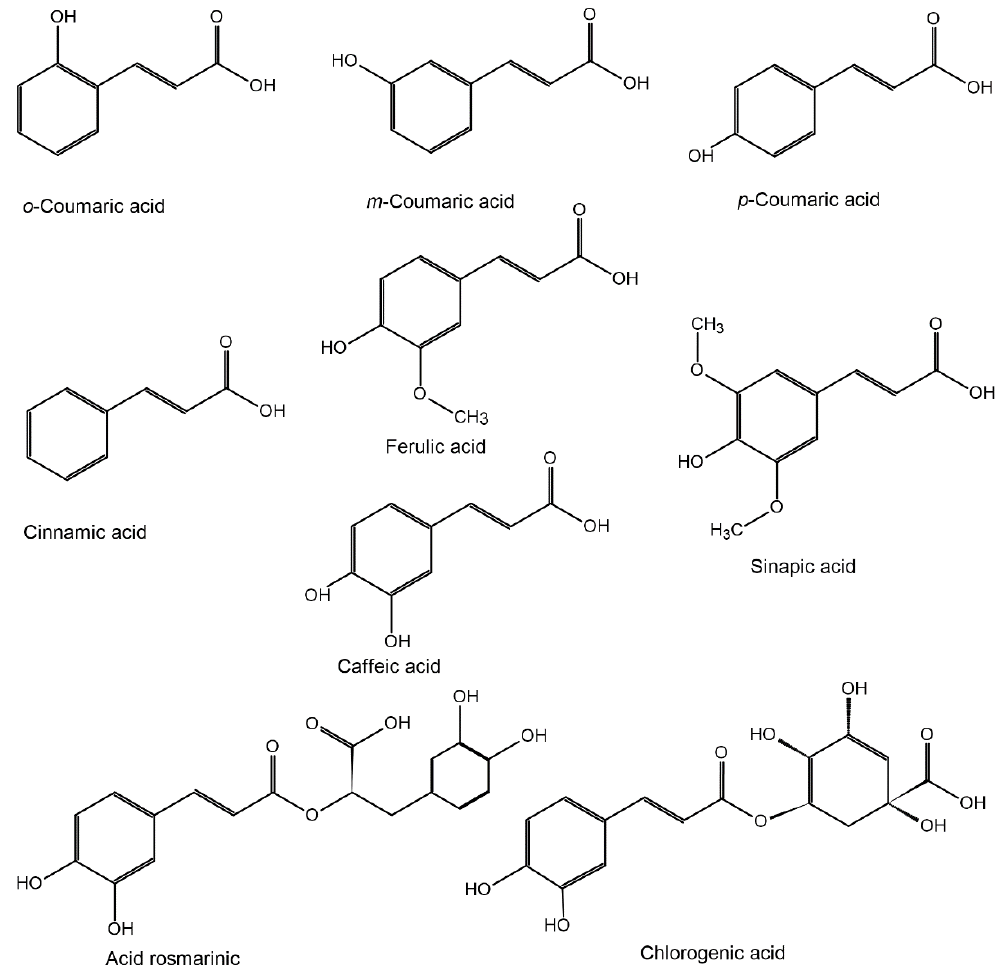
Figure 1. The structure of hydroxycinnamic acids and of their related